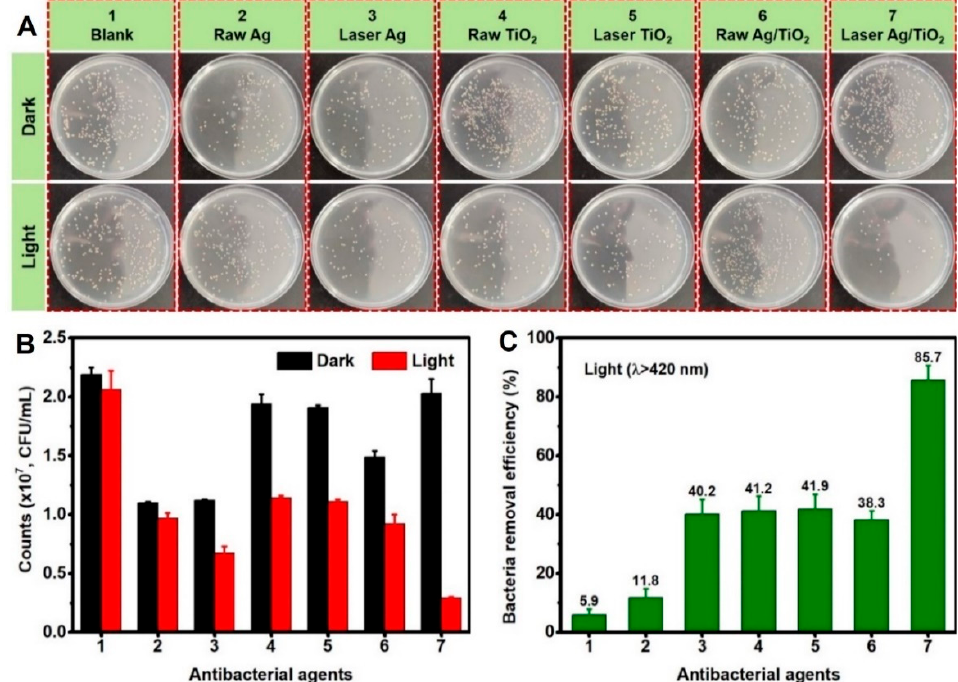
Figure 8. The antibacterial effects of different antibacterial agents under visible light or not. ( A ) The liquid broth plates supported the growth of bacteria. ( B ) The comparison of bacterial colony counts under visible light or not. ( C ) The corresponding sterilization rate over different antibacterial agents. Reprinted with permission from Ref. [44].